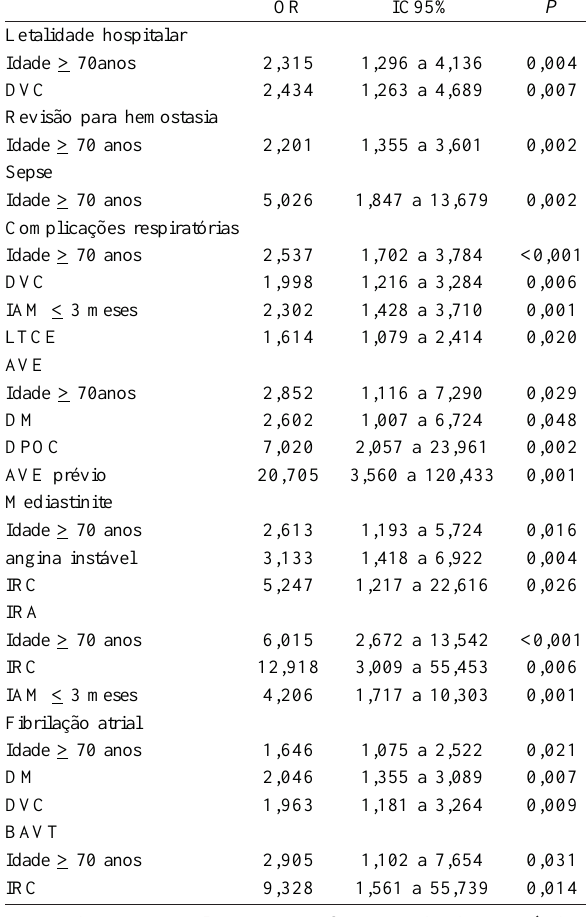
Tabela 4. Fatores preditivos de complicações pós-operatórias pela análise de regressão logística